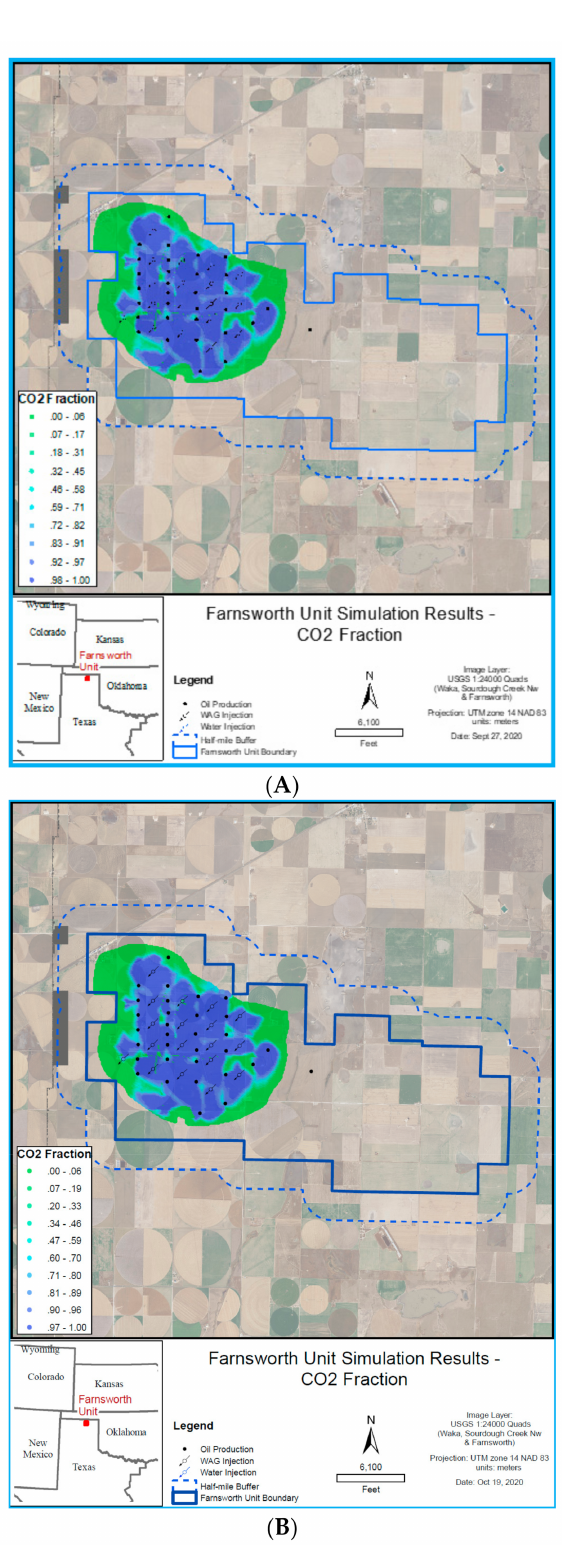
Figure 4. CO 2 Plume Extent ( A ) Before; ( B ) 5 years